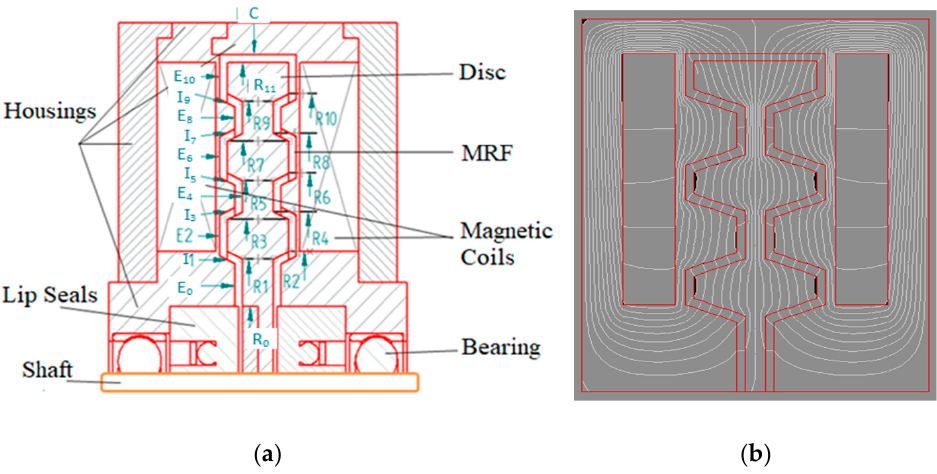
Figure 4. Proposed rotary magnetorheological (MR) brakes. ( a ) Configuration of rotary MR brakes. ( b ) Simulated magnetic flux lines.